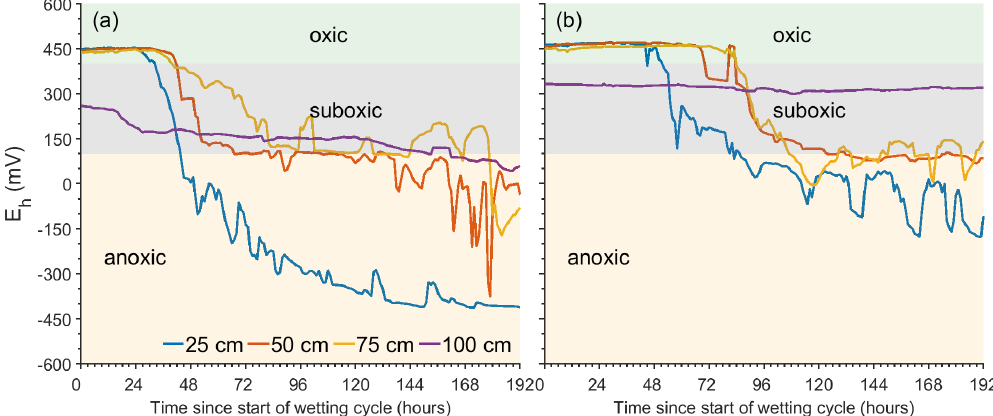
Figure 7. Plot of hourly means of E h measurements obtained at station 2, from the beginning of the wetting stages, at three depths. The statistics are based on 19 cycles during summer (May–October) and 14 cycles during winter (November–April) that were observed in (a) winter and (b) summer. Note that the data are separated between summer and winter according to the trends presented in Fig. 5. The green, grey, and yellow areas represent the oxic (400mV < ), suboxic (400mV >E h > 100mV), and anoxic E h < 100mV) conditions,